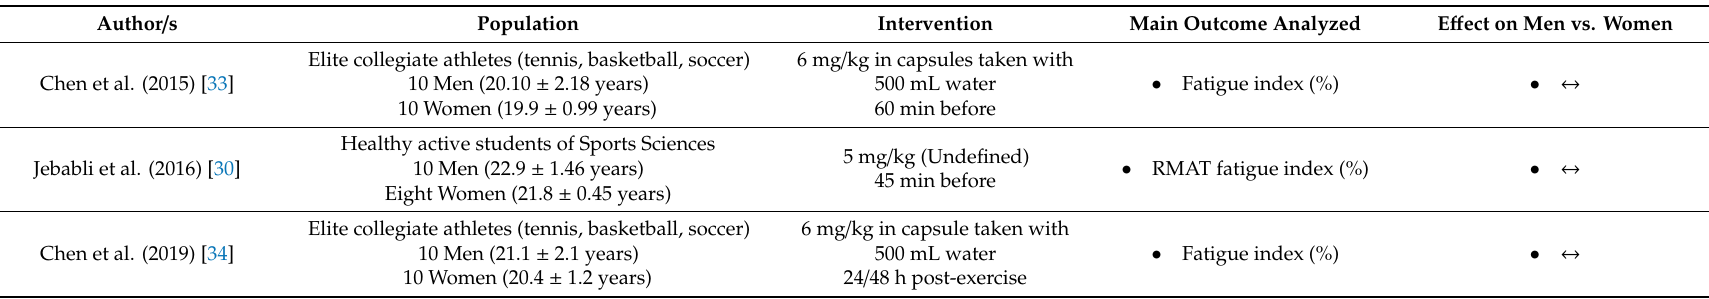
Table 3. Summary of studies included in the systematic review that investigated the e ff ect of ca ff eine ingestion between sexes on the fatigue